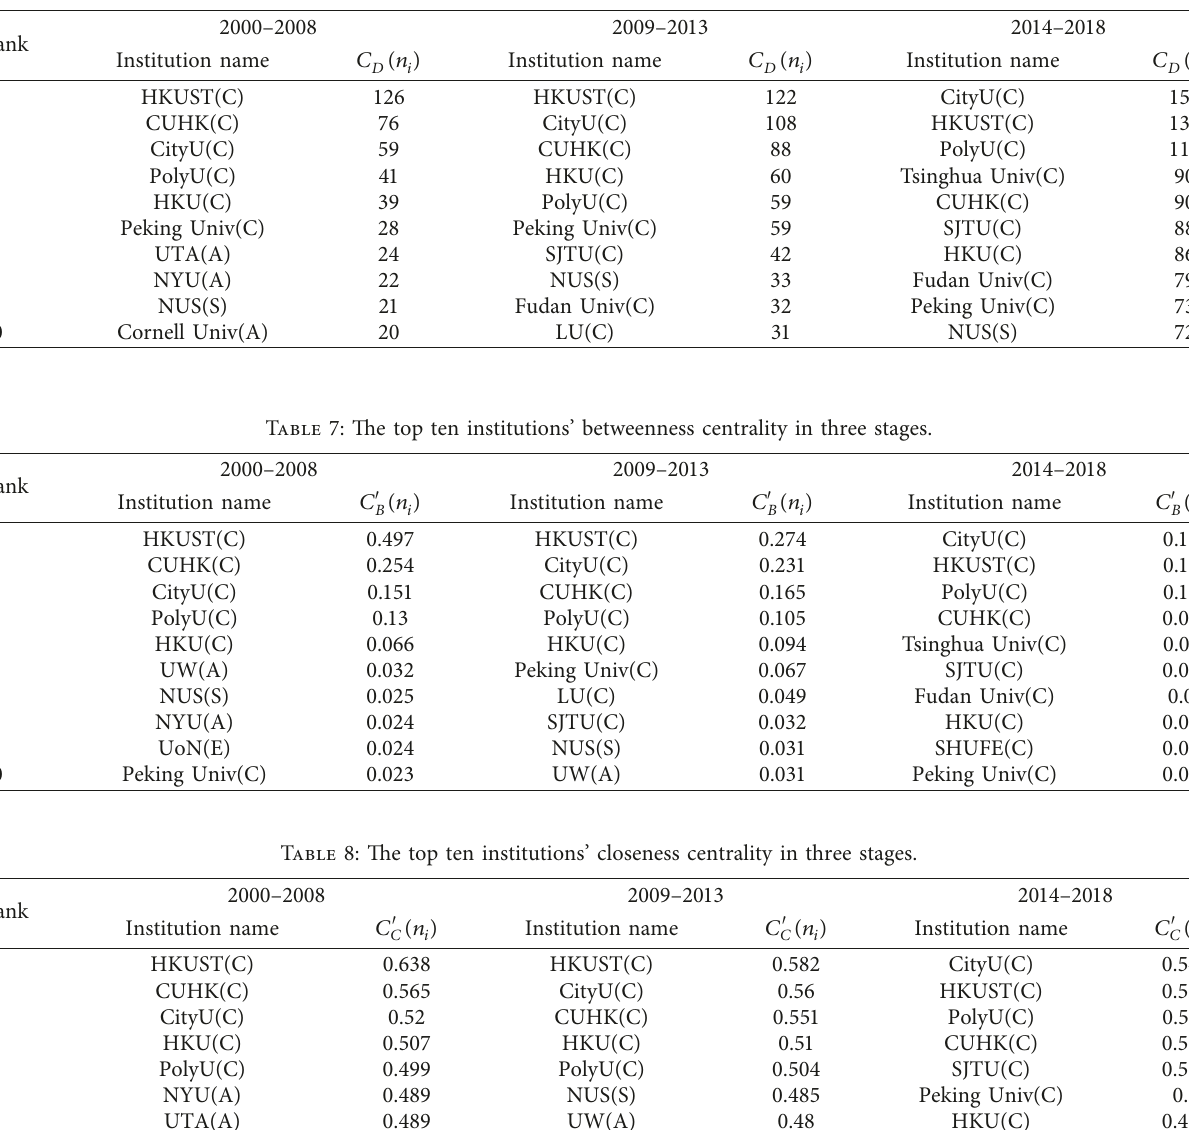
Table 6: The top ten institutions’ degree centrality in three stages.